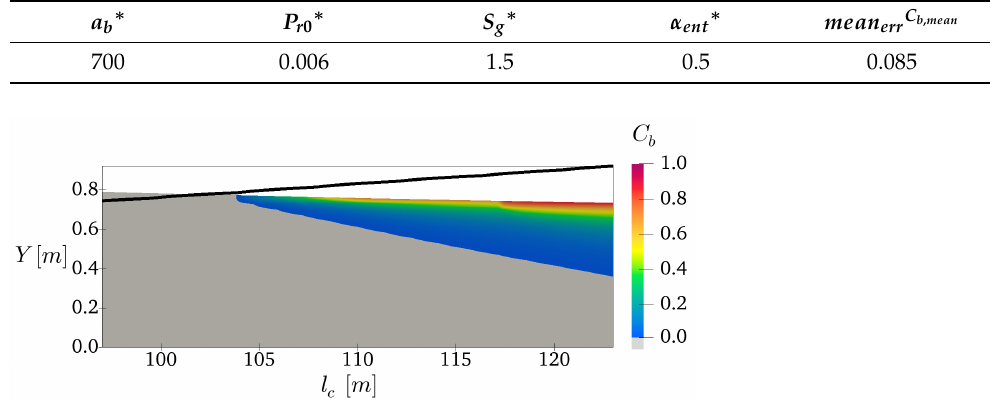
Table 3. Spillway—calibration of sub-grid model: best parameters. Entrainment formulation ‘K’.